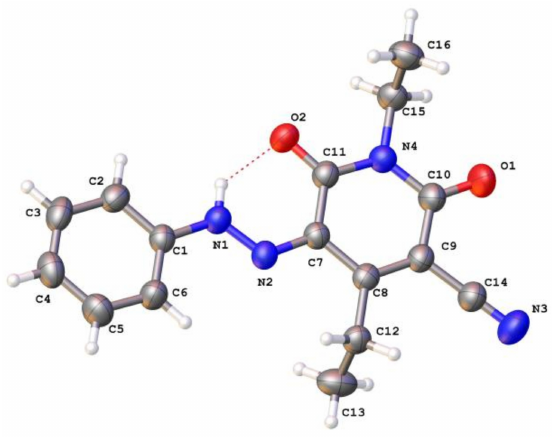
Figure 6. ORTEP of dye 30a .